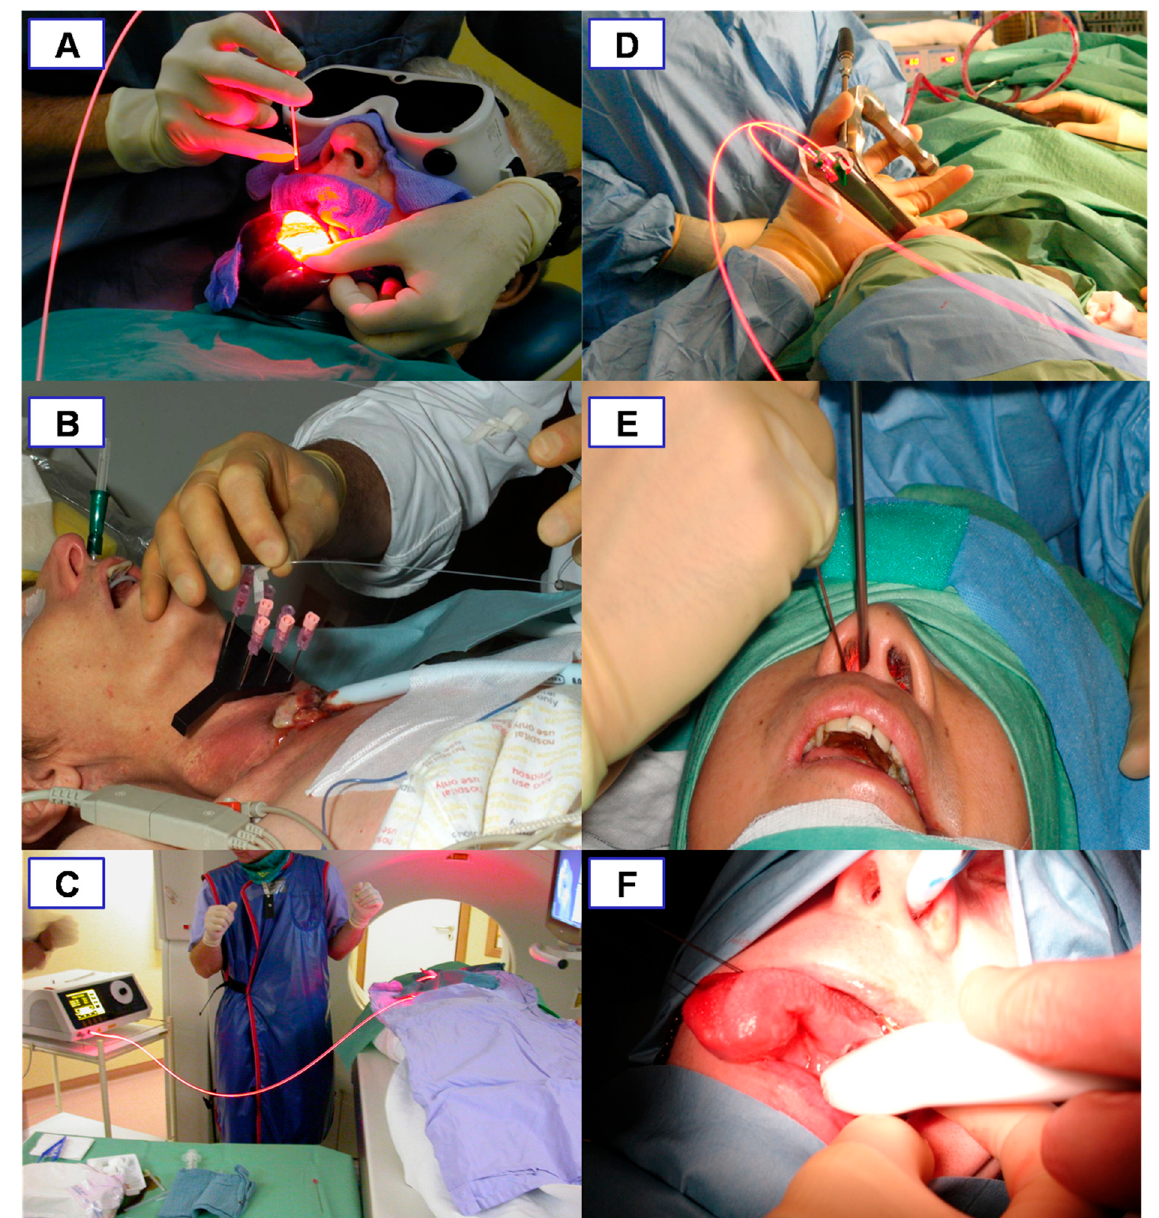
Figure 2. Mode of light delivery. ( A ): Superficial light application using a fibre-guided laser. ( B ): Interstitial photodynamic therapy using a pre-made grid to insert needles. ( C ): Interstitial photodynamic therapy with intraoperative MRI scanning. ( D ): Laryngoscopy employed to guide Photodynamic therapy(PDT). ( E ): Nasoendoscopy employed to guide PDT. ( F ): US employed to guide PDT. Reprinted with permission from ref. [10]. Copyright 2010 Clin. Oncol. (R. Coll. Radiol.)